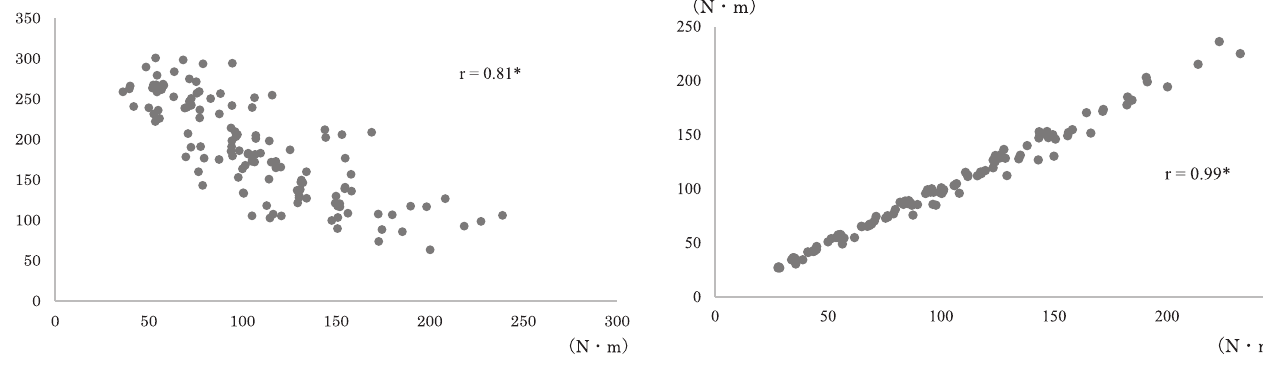
Figure 6 Correlation coefficient between angular velocity and maximum torque before modification of the leg extension machine. Spearman’s rank correlation coefficient. *p<0.01 The correlation was weaker than that in Figure 5.